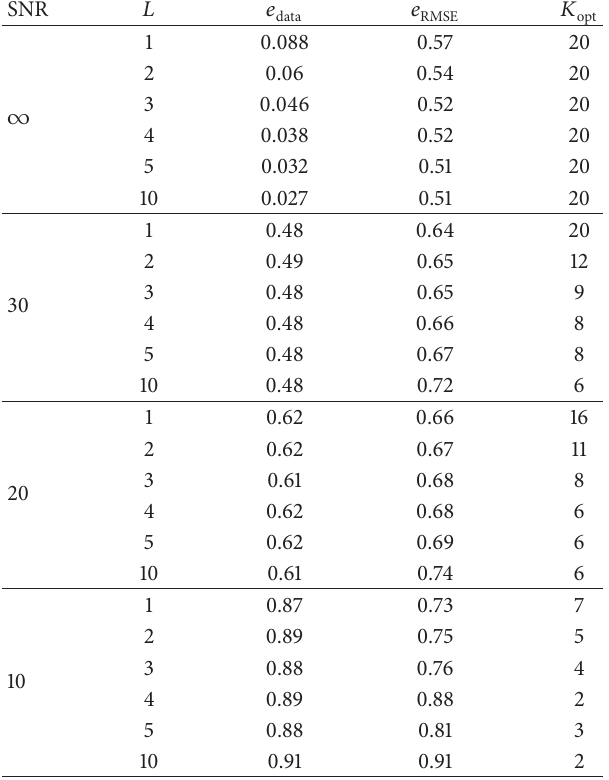
Table 1: Error measures for different values of the signal-to-noise ratio and of the number of inner iterations. Homogeneous dielectric cube.